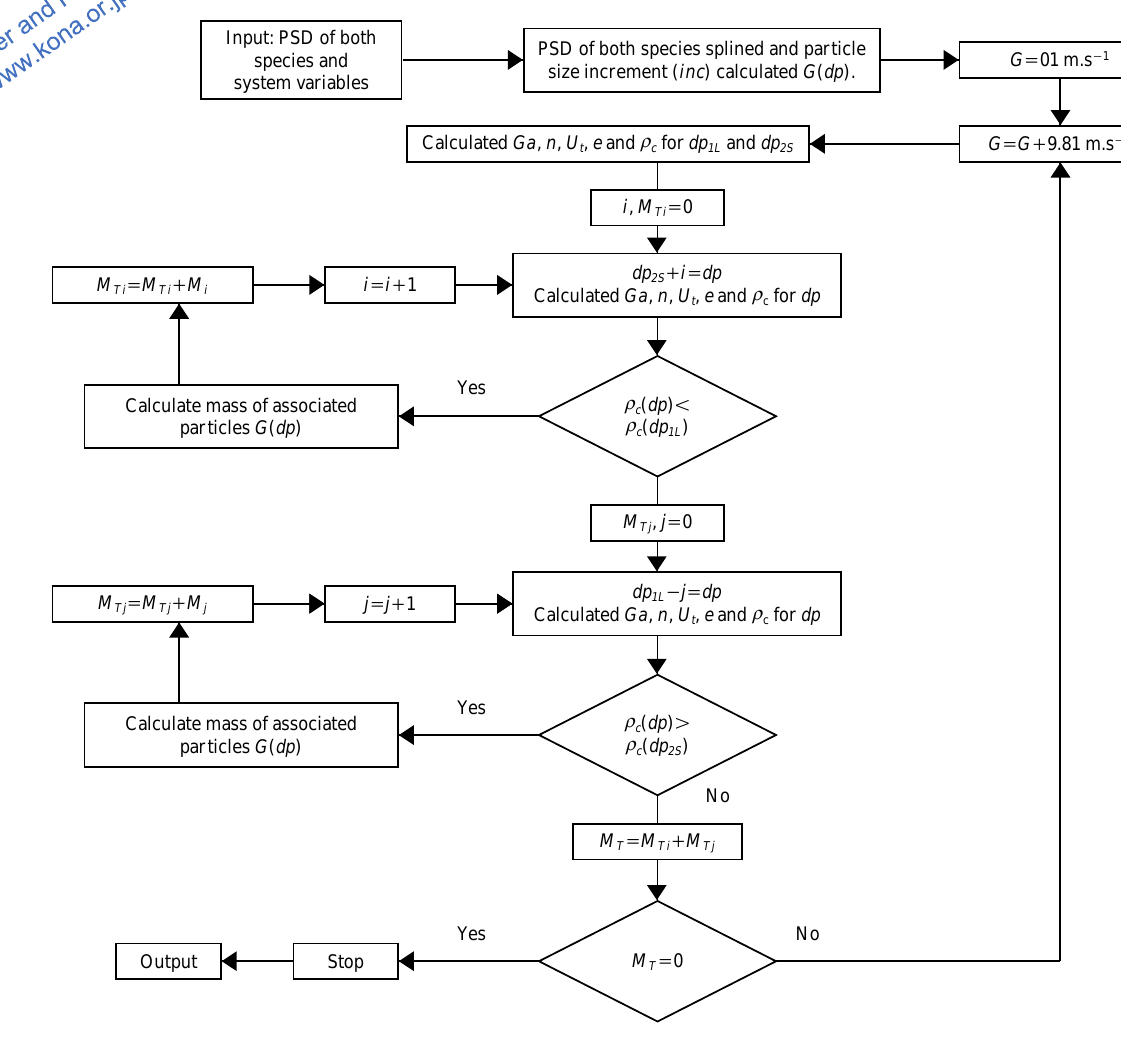
Fig. 3 The algorithm used to determine the mass of particles in the mixed (central)